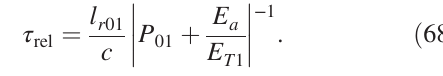
Q tot ; 1 0 . 5 E 2 E 10 E E , (b) E , (c) E , and E where E and 2 ϵ 0 a ¼ T 1 a ¼ T 1 a ¼ T 1 a ¼ T 1 T 1 ¼